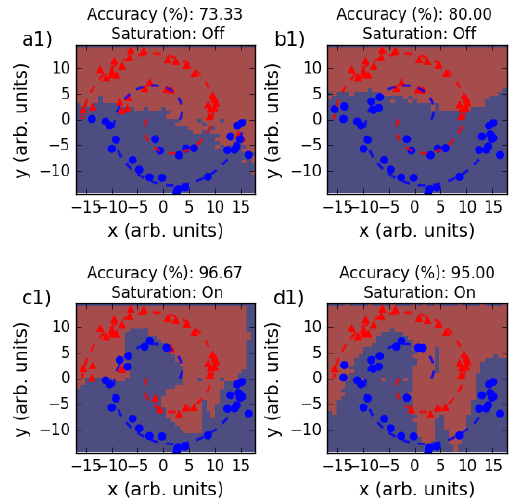
Fig. 2. Classification performance under amplitude modulation of the wavefront. a1) and b1) rely on a simple direct linear encoding mechanism according to table 1, and linear detection on the camera. c1) and d1) employ the same encodings, but with non-linear detection (i.e. camera saturation). The two classes are represented as red triangles and blue circles.